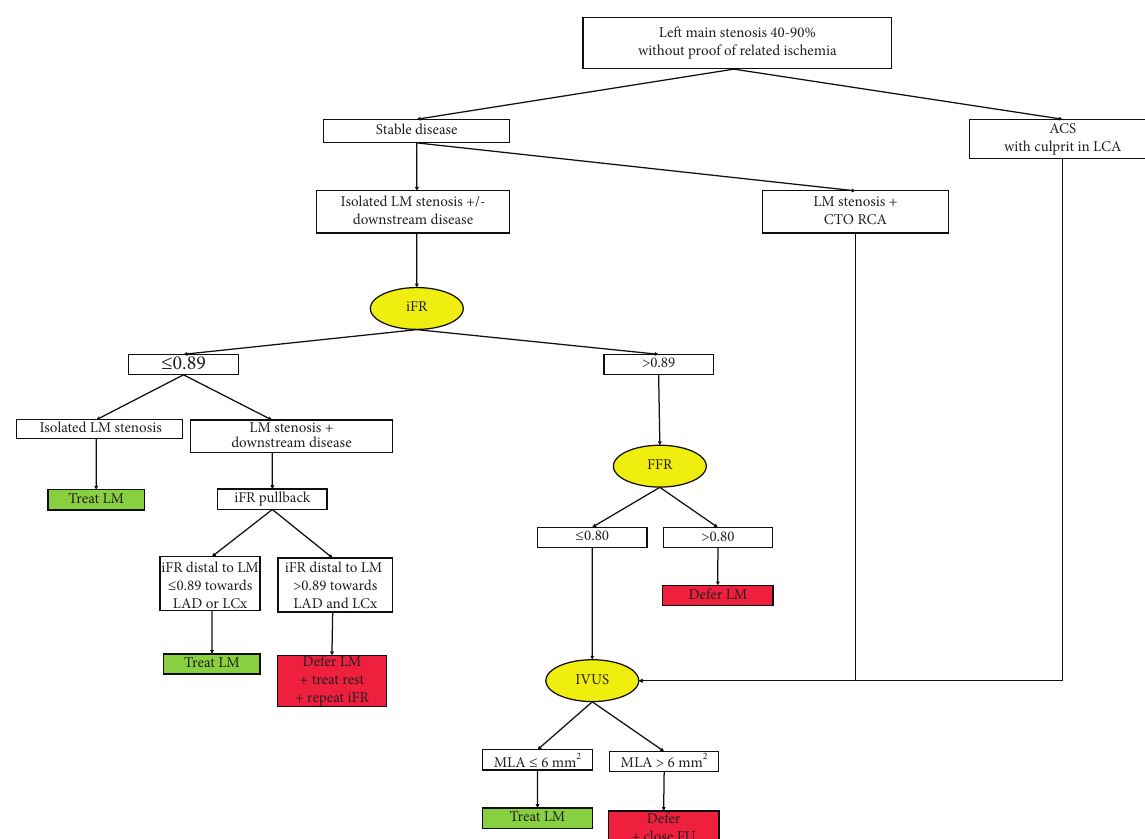
Figure 2: Our approach for intermediate LM lesions. Current approach to intermediate left main lesions in our center. The authors have a low threshold to use IVUS at any stage in the evaluation and treatment of LM lesions because of its proven added value as explained in the text. LM: left main; iFR: instantaneous wave-free ratio; FFR: fractional flow reserve; IVUS: intravascular ultrasound; ACS: acute coronary syndrome; CTO: chronic total occlusion; MLA: minimal lumen area; FU: